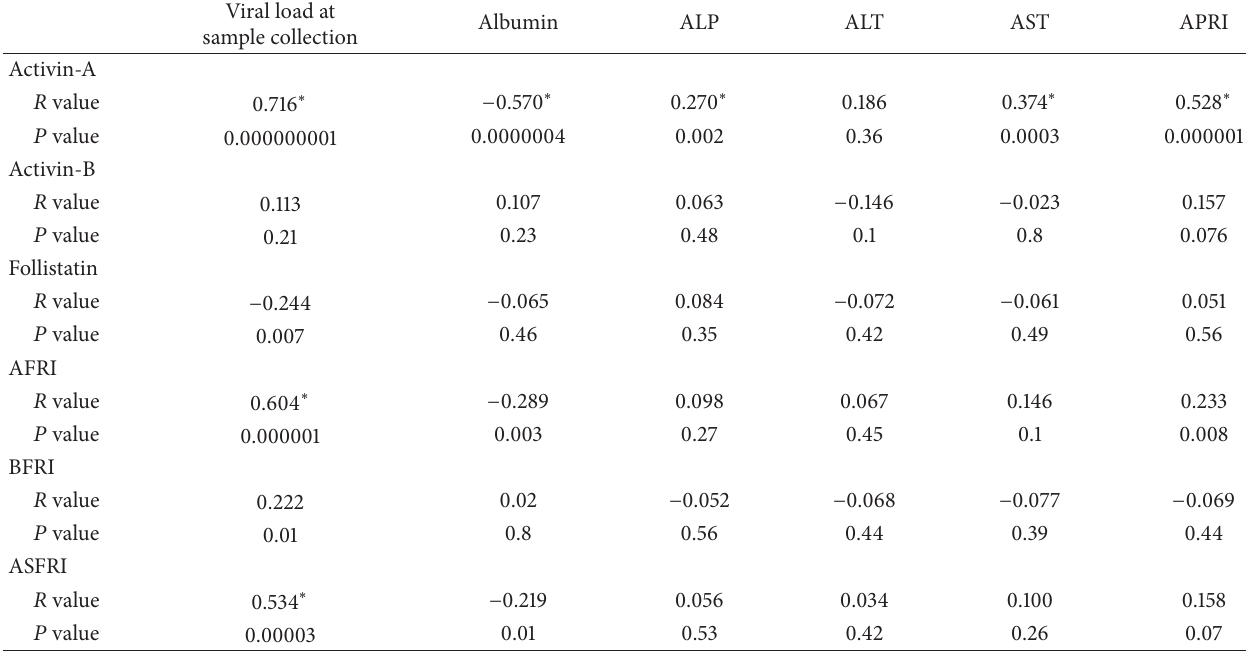
Table3:ResultsofcorrelationanalysisusingPearson’stestforactivin-A,activin-B,follistatin,AFRI,BFRI,andASFRIwithviralload,albumin, liver enzymes, and